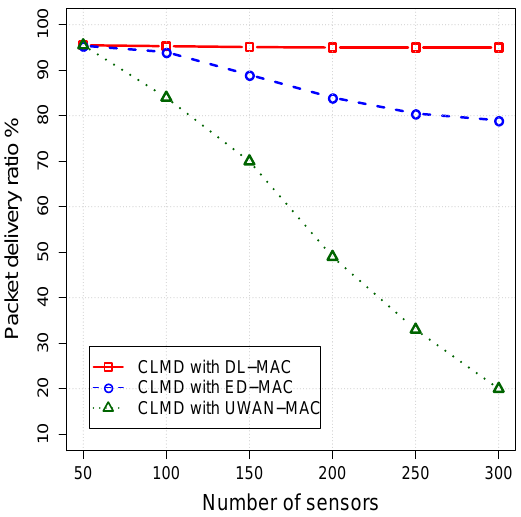
Figure 7. Packet delivery ratio vs. node